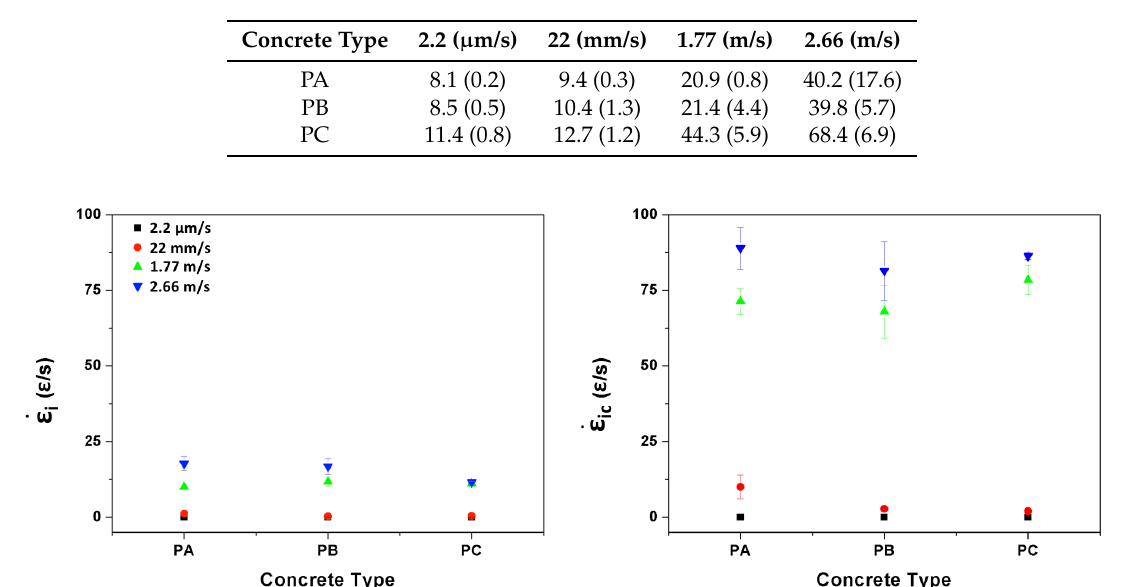
Figure 9. The strain rates ˙ ε i and ˙ ε ic upon crack initiation at the notch